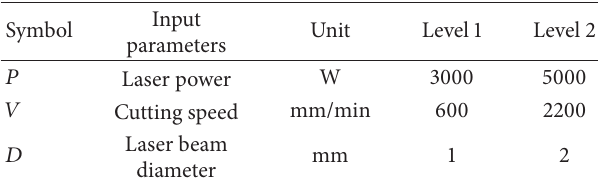
Table 3: Input laser cutting parameters and their